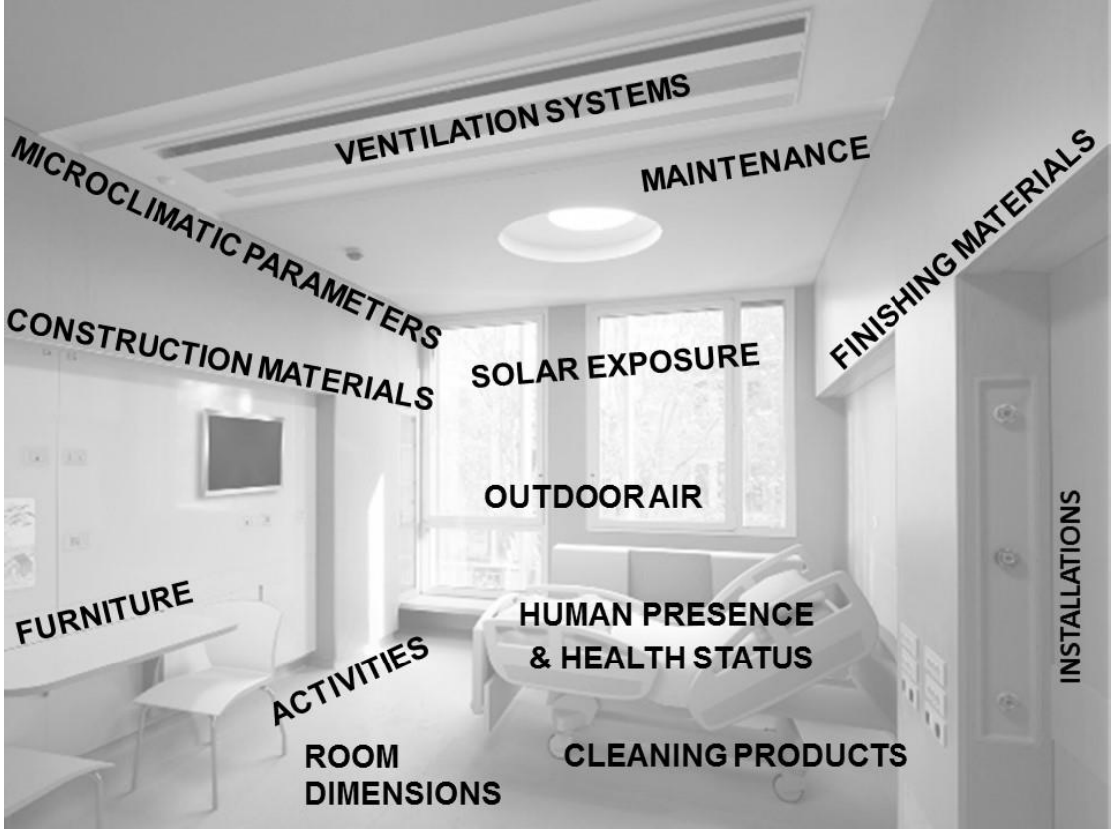
ff ect hospital Figure 1. Factors that affect hospital environments. Figure 1. Factors that a